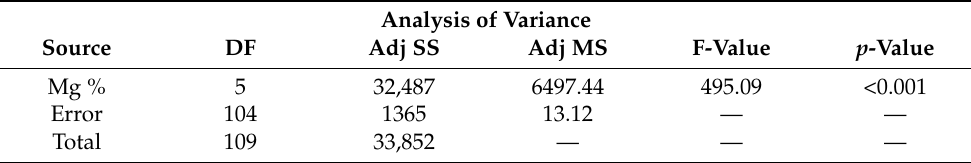
Table 6. One-way ANOVA for the effect of Mg percentage on the hardness